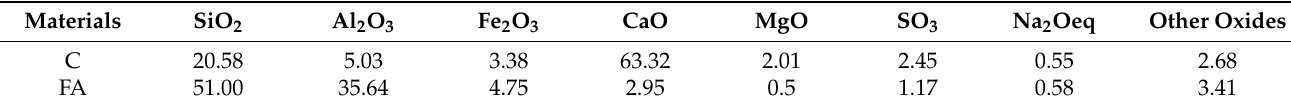
Table 3. Oxides composition of reference cement and FA (wt.%).